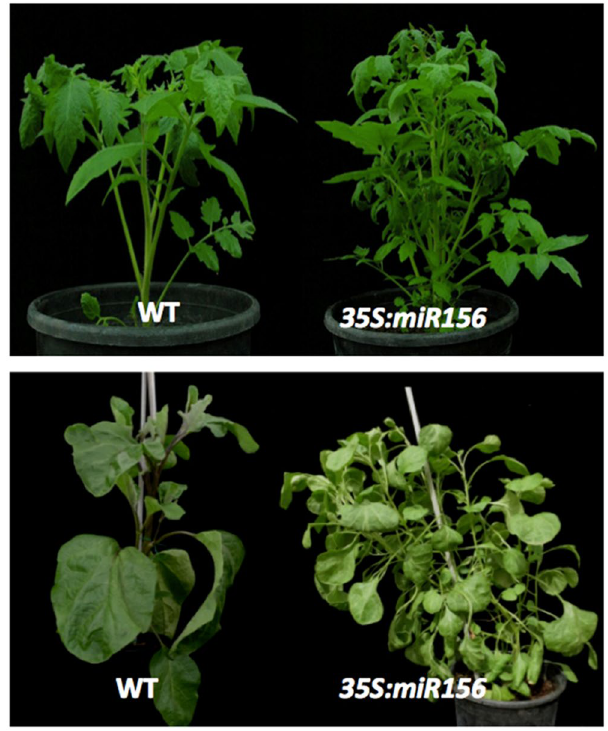
Figure 3. miR156 overexpression affects tomato and eggplant development in similar ways. MiR156 – mediated regulation of vegetative growth in tomato (upper panel) and eggplant (lower panel). Wild type plants (left) and plants overexpressing Arabidopsis miR156a (right) under the CaMV 35S